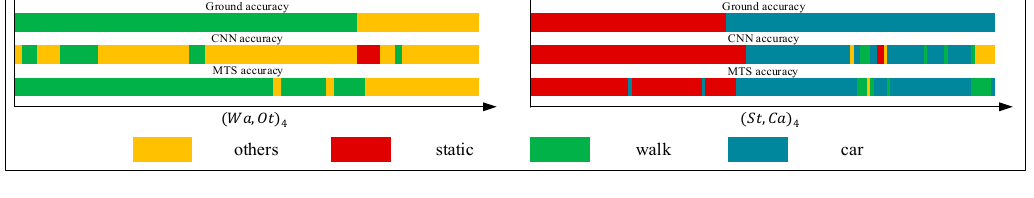
. 4 . Figure 20. Graphs of < (cid:1849)(cid:1853), (cid:1829)(cid:1853) > (cid:2872) . 5